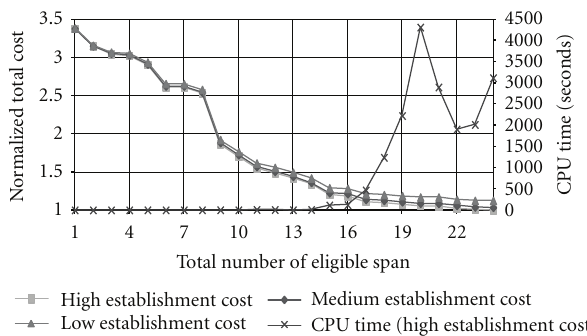
Figure 3: Total network costs and CPU time versus the number of eligible spans for the 15-node network.